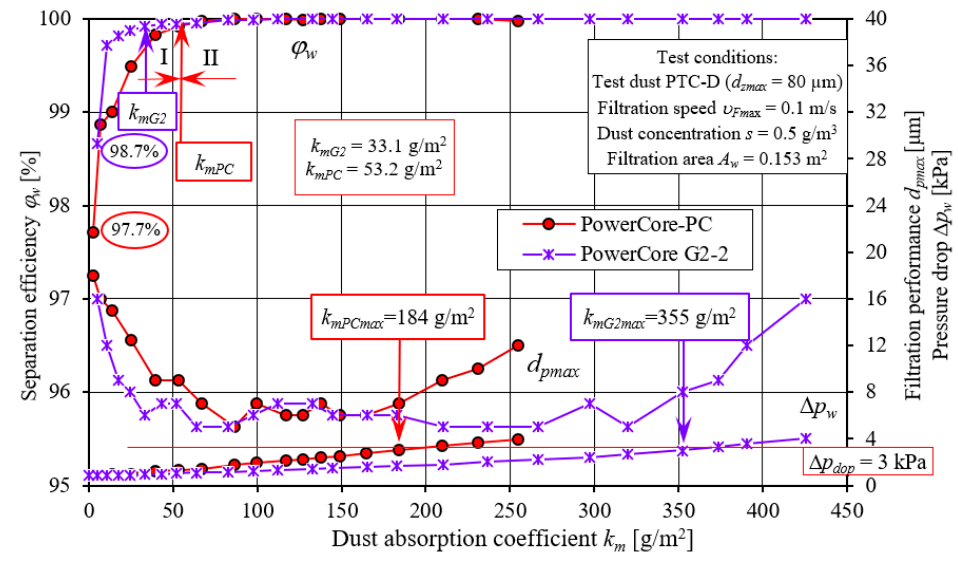
Figure 19. Characteristics of efficiency ( ϕ w ) and filtration performance ( d pmax ) and pressure drop ( ∆ p w ) depending on the dust absorption coefficient ( k m ) of PowerCore—PC and PowerCore—G2 research filter cartridges.